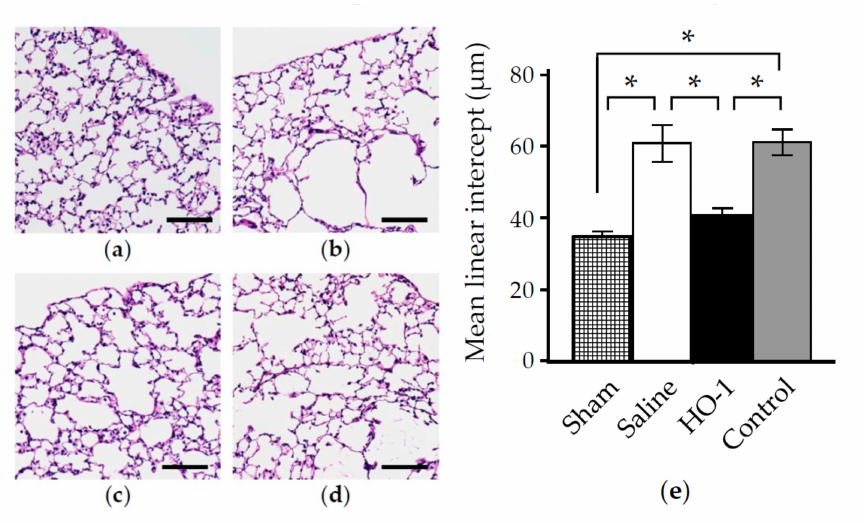
Figure 8. E ff ect of nasal administration of HO-1 lactis on PPE-induced emphysematous morphologic changes. Mice were treated as described in Figure 5. Lungs were collected at day 21, and representative images of Hematoxylin and Eosin (H&E)-stained lung specimens are shown ( a – d ; scale bars = 100 µ m). ( a ) Sham. ( b ) Saline. ( c ) HO-1 lactis. ( d ) Control lactis. ( e ) Mean linear intercept was measured in 10 randomly selected microscopic fields for each specimen, calculating a total of 60 fields of Lm / group. Results represent the mean ± SE of 2 independent experiments involving a total of 6 mice / group. *, p <